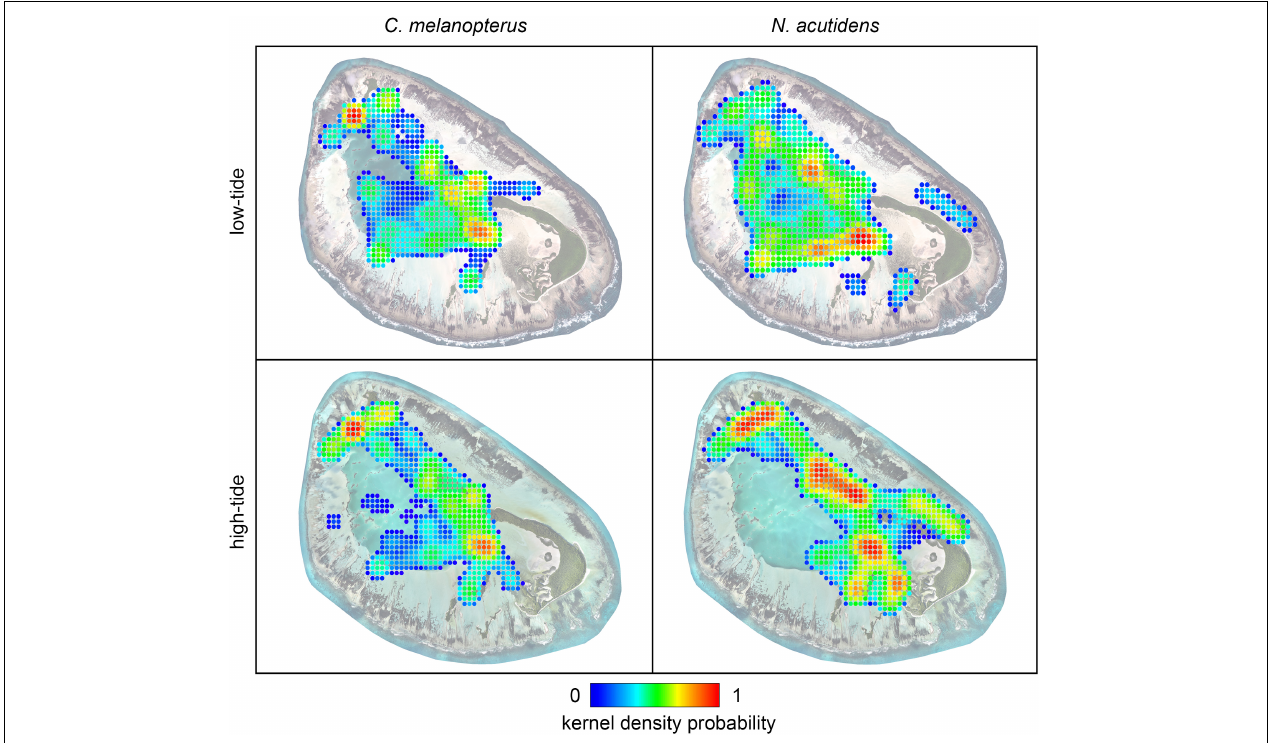
FIGURE 4 | 50% kernel density plots with a 0.1 km cell size showing how space use differs between high ( > 1.4 m) and low ( < 1.4 m) tides for blacktip reef shark Carcharhinus melanopterus and sicklefin lemon shark Negaprion acutidens . Values closer to one represent prolonged occupancy. The satellite image of St Joseph at low tide was acquired from LAND INFO Worldwide Mapping, LLC (Denver, CO, United States), and includes material Copyright DigitalGlobe (Longmont, Colorado). The high-tide image of St Joseph was provided courtesy and Copyright of Drone Adventures for the Save Our Seas Foundation. The maps were produced using ArcGIS (ESRI Inc., CA, United